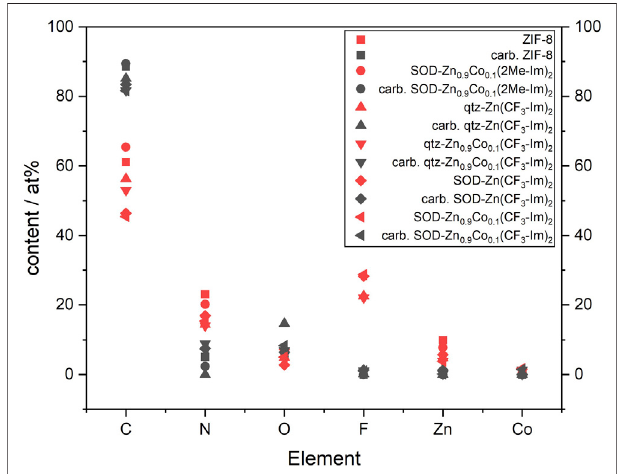
FIGURE 8 | Relative elemental composition of pristine ZIFs (red) and after pyrolysis (grey). Due to decomposition the amount of N, F and Zn decrease,whileCand Orise. AllCo-containingsamplesretainCoin thesame order of magnitude.